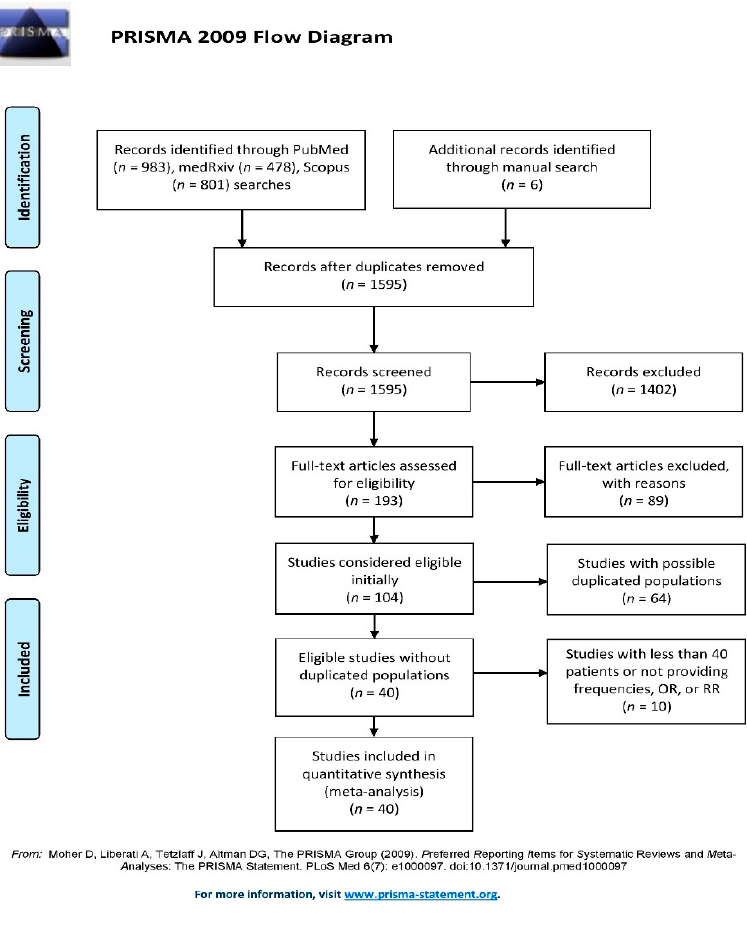
Figure 1. PRISMA Flow Diagram. Table 1. Characteristics of the included studies. COPD and Asthma analysis cohorts.